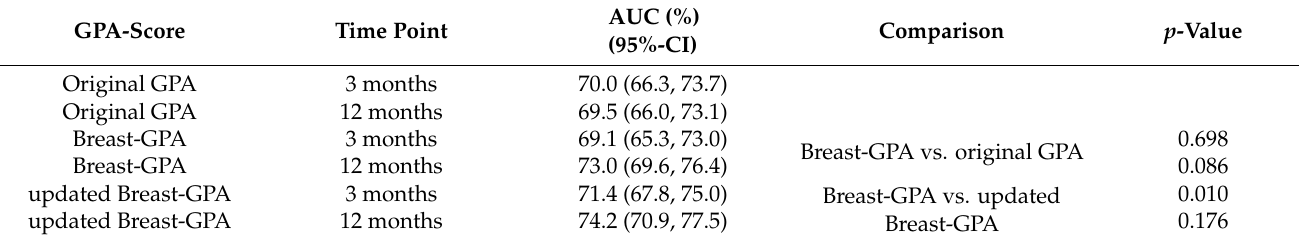
Table 7. Area under the time-dependent Receiver Operating Characteristic (ROC) curve (AUC) with the corresponding 95%-CI for all three GPA-Scores for two different time points (3 and 12